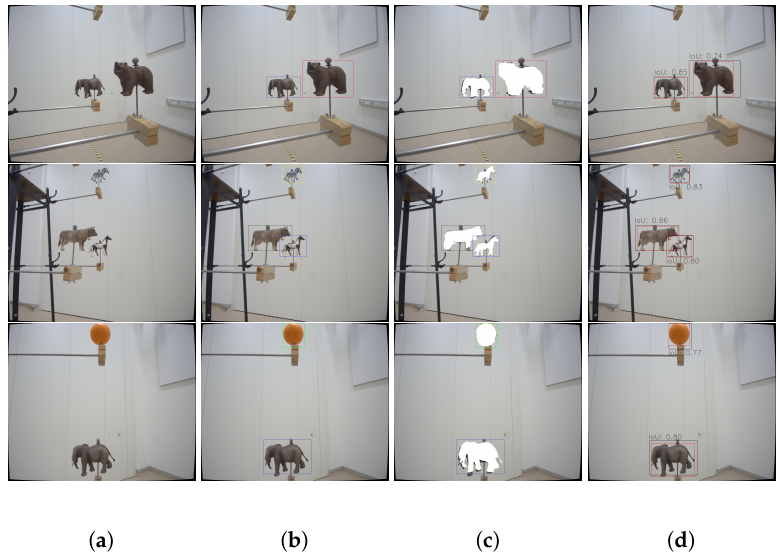
Figure 8. Comparison of our bounding box annotation results to manual annotation. For better visualization, we focus the comparison to close-up recordings of the objects. ( a ) (Original Image) shows the original image, ( b ) (Annotation) the bounding box created by our pipeline, and ( c ) (Binary Masks) additionally includes the corresponding binary masks. Finally, in ( d ) (Comparison), we compare our pipeline’s annotation to the manual annotation, plotted in black and red, respectively. Moreover, we also plot the IoU scores for corresponding bounding box pairs. Best viewed as PDF and in color.